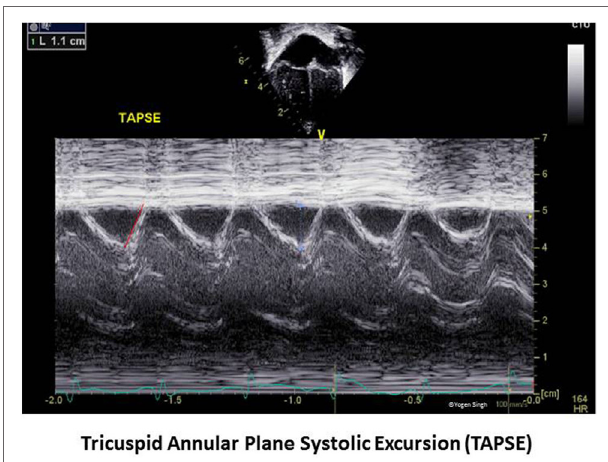
FiGURe 8 | Tricuspid annular plane systolic excursion (TAPSE) measurement on echocardiography. TAPSE reflects the longitudinal movement of the tricuspid annulus toward apex in systole measured on M-mode in apical four-chamber